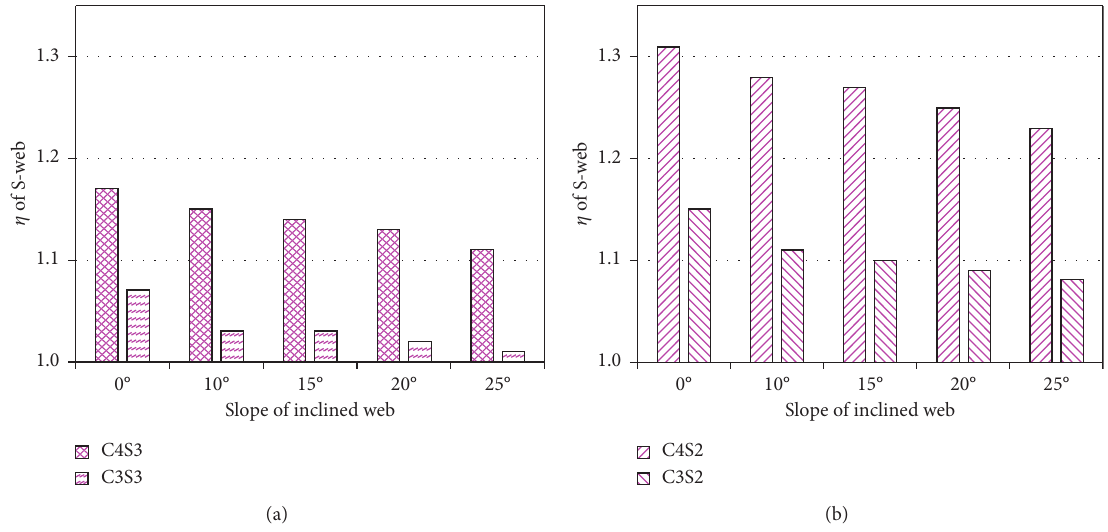
Figure 7: Effect of cell number. (a) C4S3 and C3S3. (b) C4S2 and